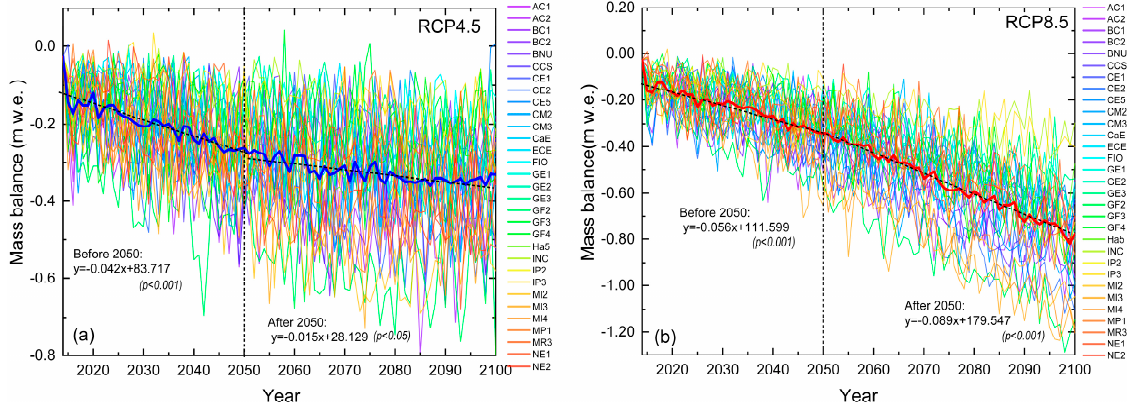
Figure 12. The annual surface mass balance was projected in RCP 4.5 ( a ) and RCP 8.5 ( b ) scenarios during 2014–2100. The thick dashed thick lines refer to the mean value of ensembles.